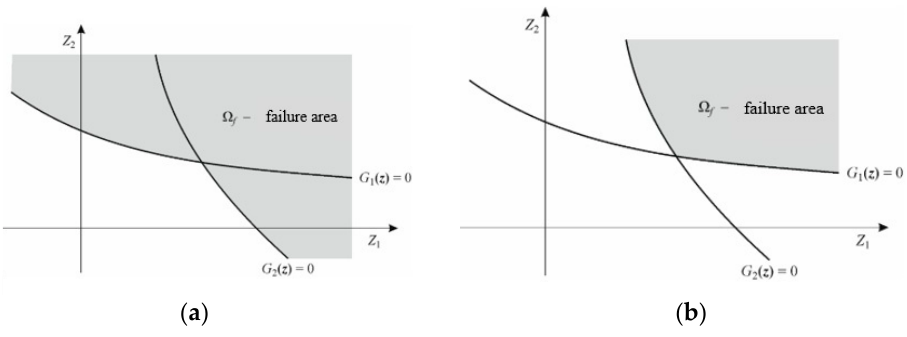
Figure 1. Failure areas for: ( a ) series system, ( b ) parallel system.